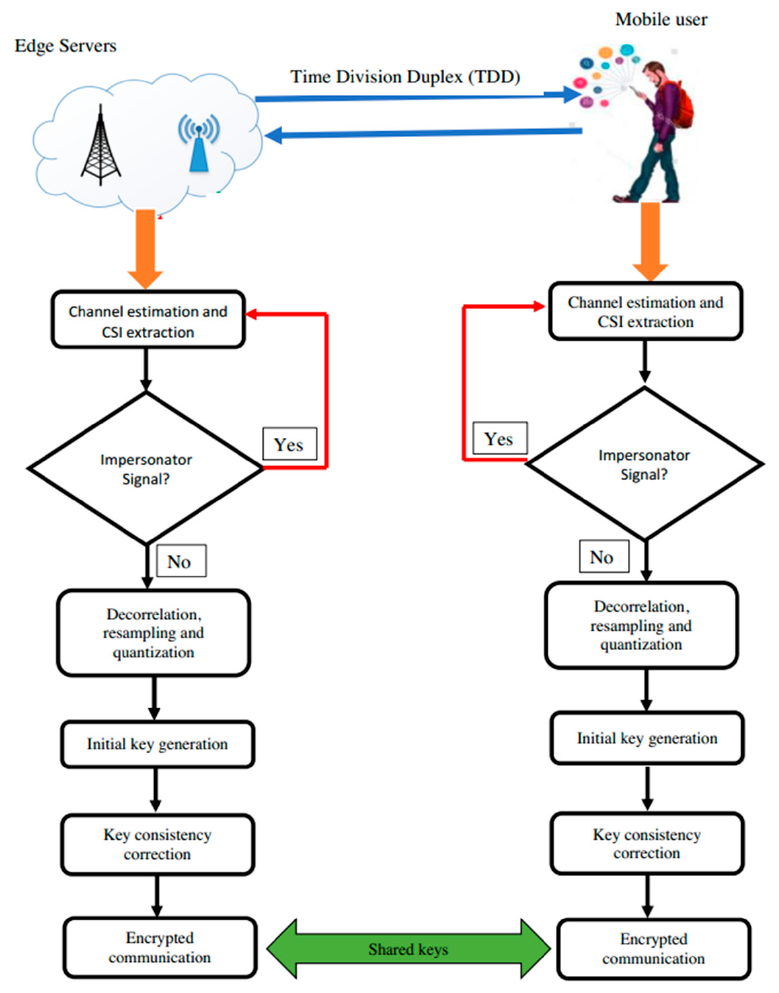
Figure 2. The key generation model.